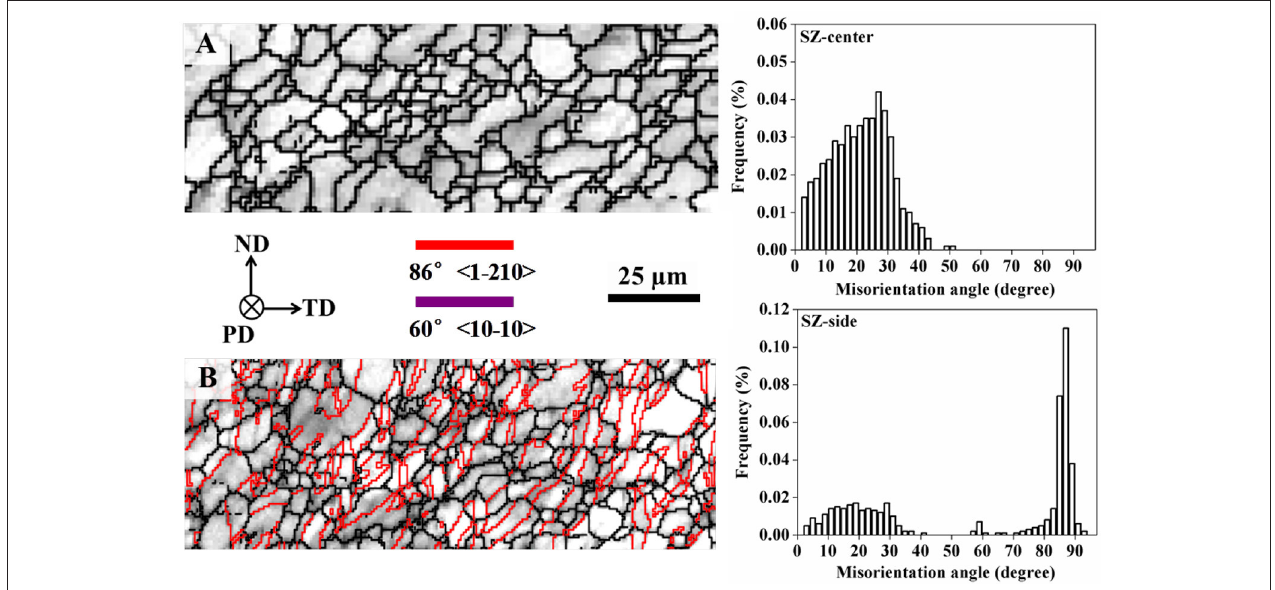
FIGURE 6 | EBSD orientation maps of the (A) SZ-center and (B) SZ-side after ∼ 5% strain along TD and the corresponding misorientation angle distributions (Xin et al., 2012 ) (Copyright © 2012, Springer Nature).